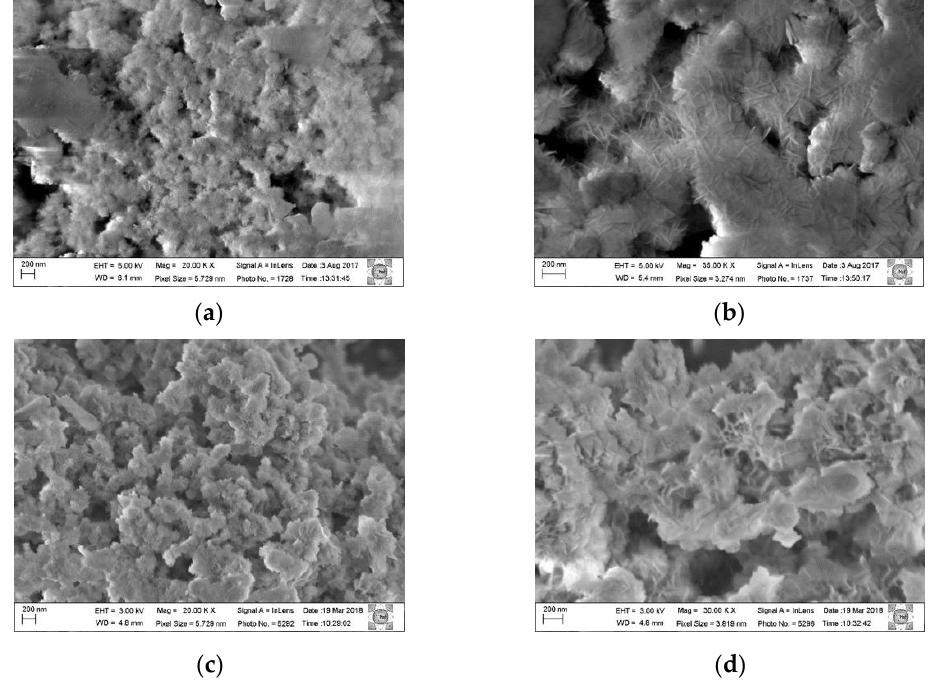
Figure 3. Micrographs of Al,Mg-LDH samples: ( a , b ) as-synthesized Al,Mg-LDH sample and ( c , d ) calcined sample under O 2 flow and rehydrated with H 2 O vapor.